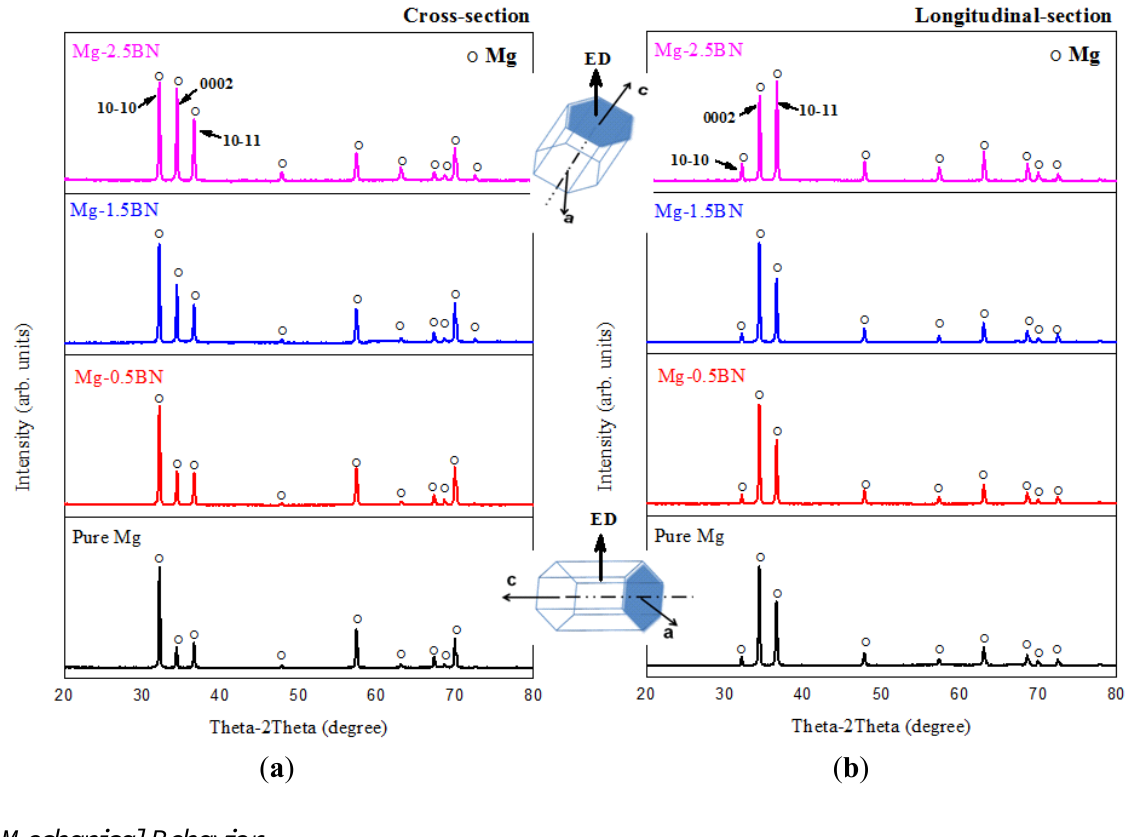
Figure 3. Results of X-ray characterization studies conducted along the ( a ) cross section; and ( b ) longitudinal sections on the extruded rods of developed Mg based